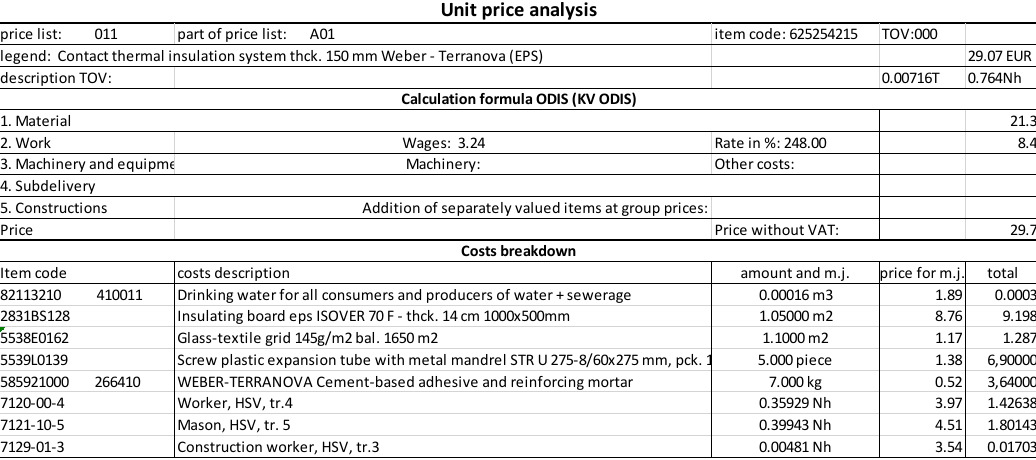
Figure 4. Calculated profit according to New Calculation Formula (NCF) methodology.